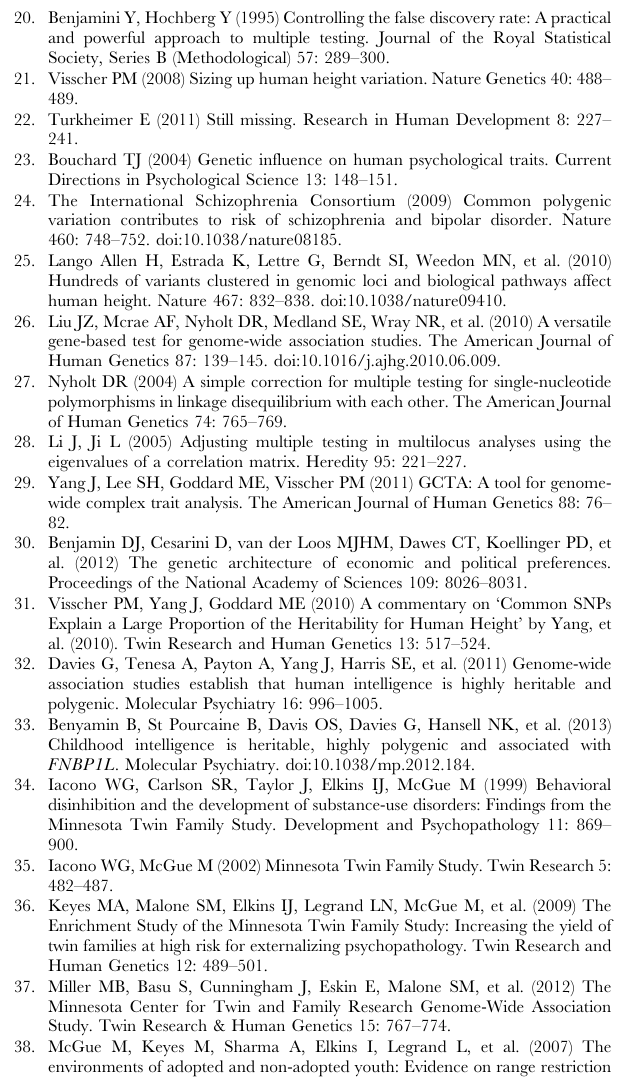
Figure S7 Five-fold cross-validation of polygenic score, predict- ing FSIQ residuallized for covariates. Figure depicts cross- validation Buse’s R 2 for predicting residuallized FSIQ in the indicated subsample from polygenic score calculated from regression weights obtained in the other 4 subsamples. ‘‘ P -value cutoff’’ dictated how small a SNP’s p -value had to be in the calibration GWAS to be included in calculating polygenic score for the validation sample. Polygenic score was either calculated directly from the GWAS weights (solid lines) or from signed unit weights (dashed lines; see text). Figure S8 Normal quantile-quantile plots of predicted GCTA random effects. The left-hand panel depicts empirical best linear unbiased predictions (eBLUPs) of 3,322 participants’ total genetic effects, i.e. g in main-text Equation (4), conditional on the fixed effects. The right-hand panel depicts those participants’ residuals, given the fixed effects and the eBLUPs of g . As explained in the text, quantile-quantile plots of eBLUPs should be interpreted cautiously.